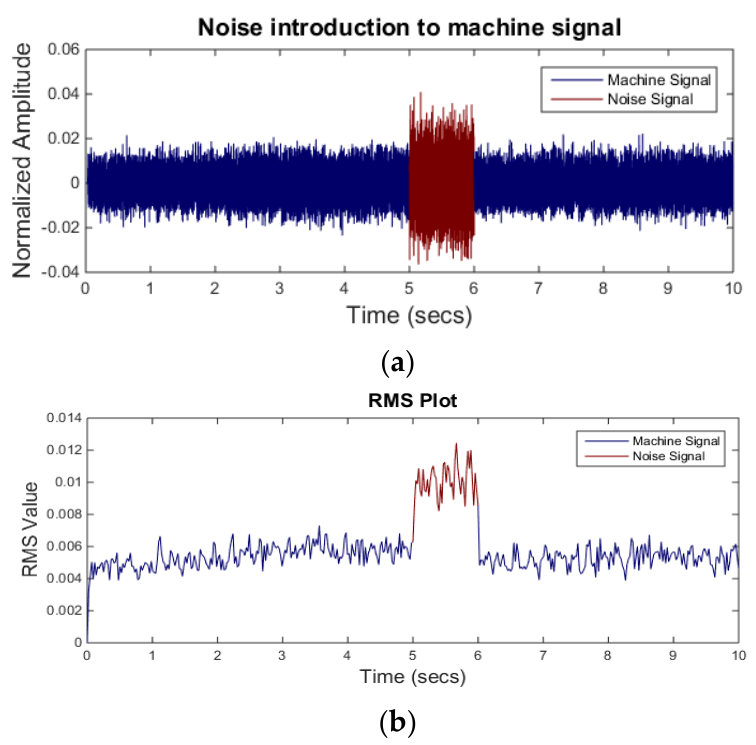
Figure 9 . ( a ) Noise introduction (above) and ( b ) RMS level of the same signal (below). FFT plot of the machining signal is shown in Figure 10a before adding the noise. Four dominant peaks of the machining signal at 2.332 kHz, 2.336 kHz, 2.352 kHz, and 2.358 kHz can be seen in the figure. Figure 10b shows the FFT of the machining signal after mixing with background noise. It can be seen from Figure 10b that an additional peak at 2.340 kHz is added to the plot. In addition to that it can also be observed that amplitudes of the dominant peaks are also affected by the noise. Hence, it validates the hypothesis that signal cannot be analyzed in the frequency domain as the background noise frequency may fall within the machining signal frequency of interest. The noisy signal is then passed through the back-propagation neural network. Figure 11 shows the filtered signal. It is observed that RMS values between 220 and 264 sample numbers which correspond to the noisy patch in the signal are filtered. However, some other values from the machining signal are also wrongly classified. To reconstruct the filtered signal a time series model ARMA-based algorithm is de- veloped. To estimate the order of the ARMA model, a minimum of 50 points is needed; therefore, to make the signal continuous or to reconstruct the filtered values for the first 50 samples, the filtered values are initially replaced by the average of the two neighbor samples. A variance test has been used to check the stationarity of the signal. The variance of the signal is calculated and recorded for the series and then the series is differenced until minimum variance is found which is equal to 1. Therefore, one difference in the series is taken. Table 4 shows the different values of variance calculated at a different order of difference. It can be seen that variance is minimum at